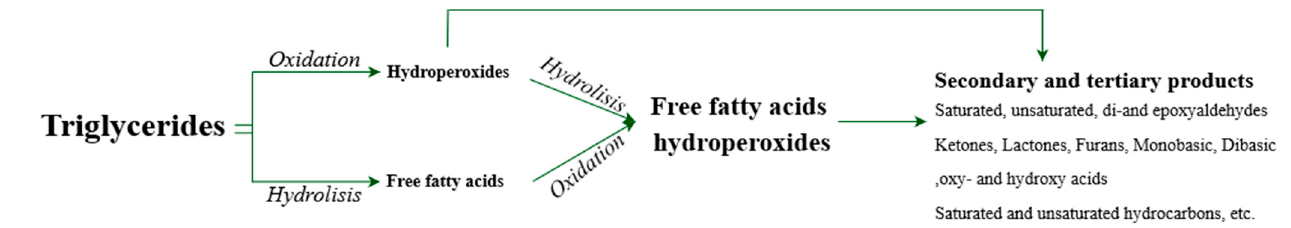
Figure 9. Oxidative and hydrolytic degradation reaction pathways in VOs.